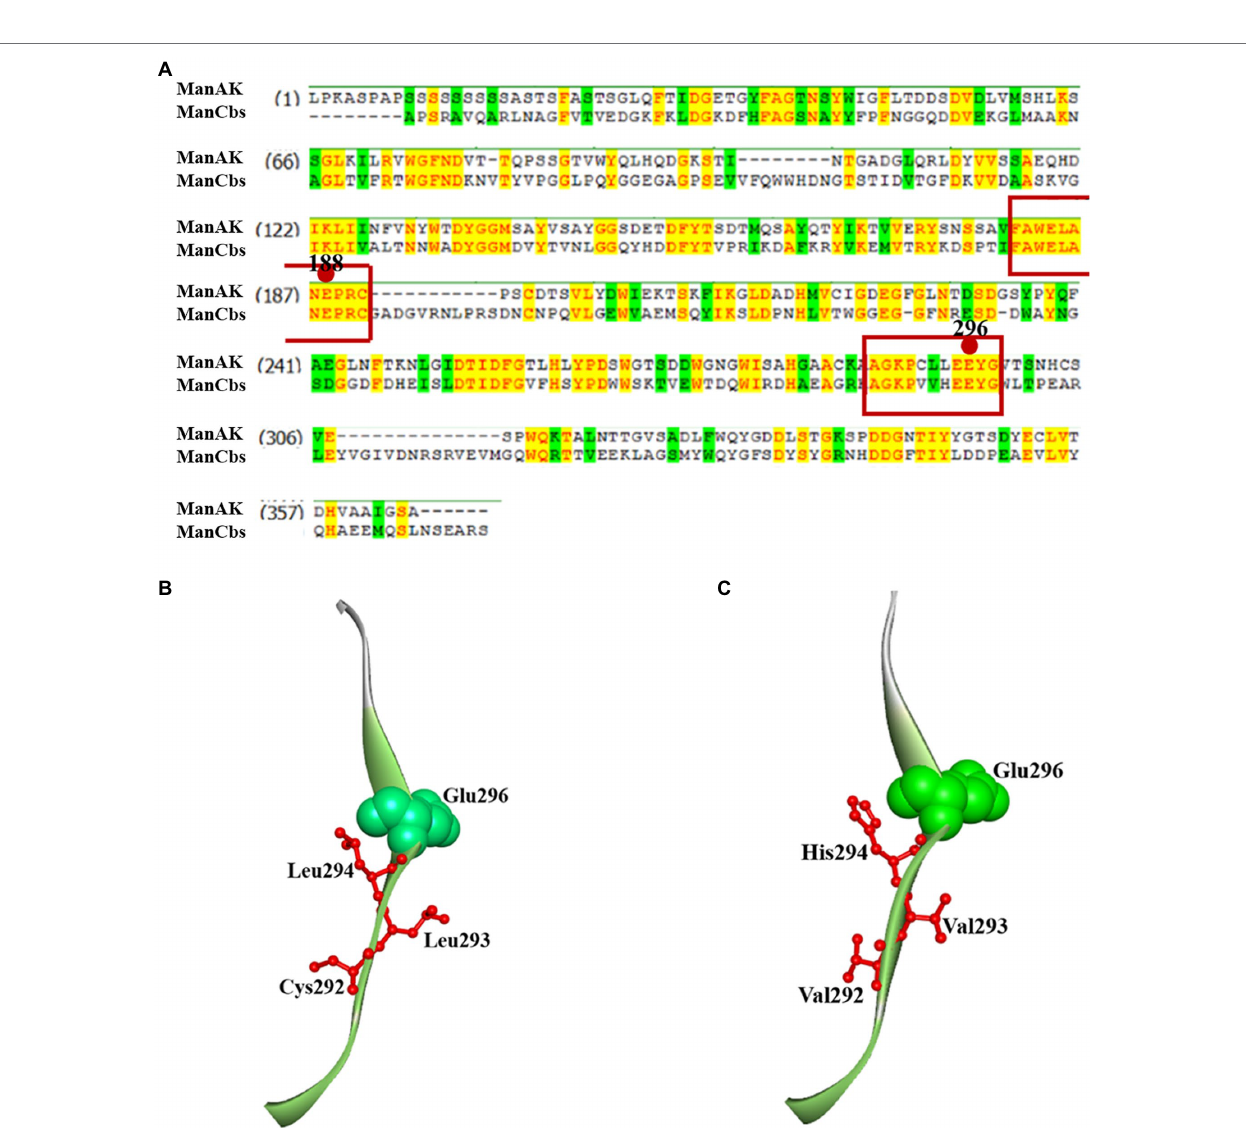
FIGURE 1 | Amino acid consensus sequence analysis and secondary structure around E296 of thermostable and acidophilic β -mannanase (ManAK) and ManCbs. (A) Amino acid consensus sequence analysis of ManAK and ManCbs. Strictly conserved residues are shaded yellow. The active site residues in catalytic regions are boxed and circles indicate the catalytic sites in catalytic region. (B) Secondary structure around E296 of ManAK. (C) Secondary structure around E296 of ManCbs. The amino acids in position 292, 293, and 294 are indicated in red, and E296 is indicated in green